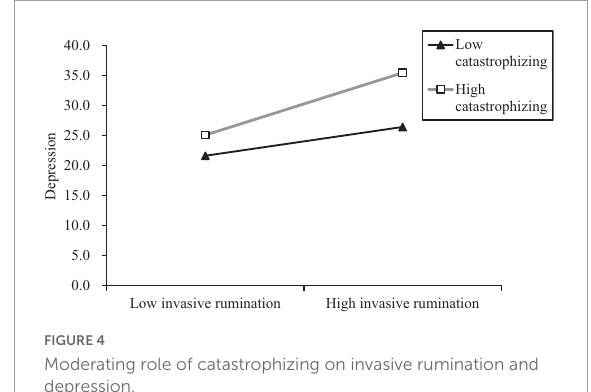
FIGURE4 Moderating role of catastrophizing on invasive rumination and